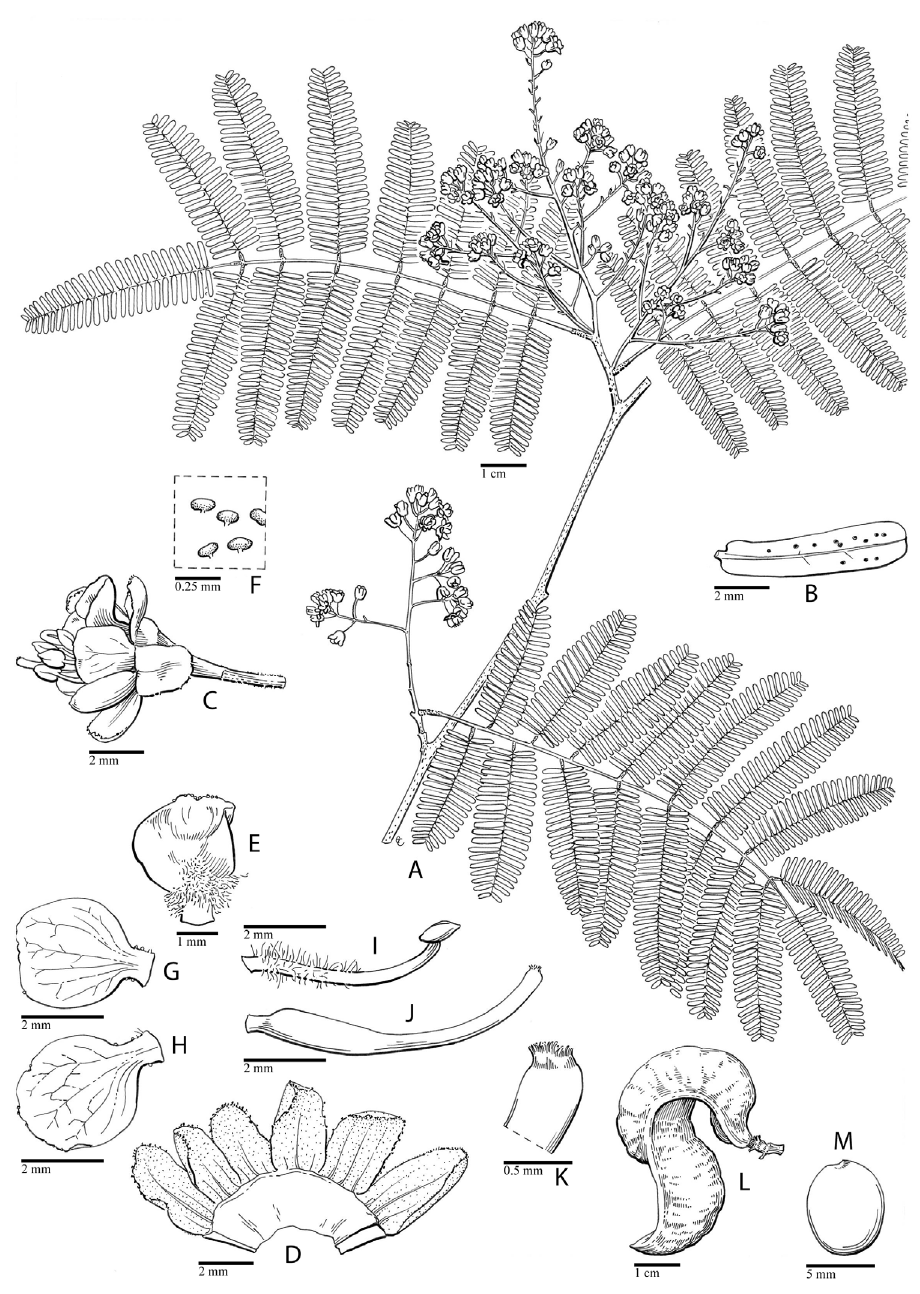
Figure 31. Libidibia coriaria. A inflorescences and foliage B leaflet undersurface showing glands C flower D calyx opened out E median petal F detail of glands on back of median petal G upper lateral petal H lower lateral petal I stamen J gynoecium K stigma L fruit M seed. A–C from Hughes 1495 D–M from Macqueen 8. Drawn by Eleanor